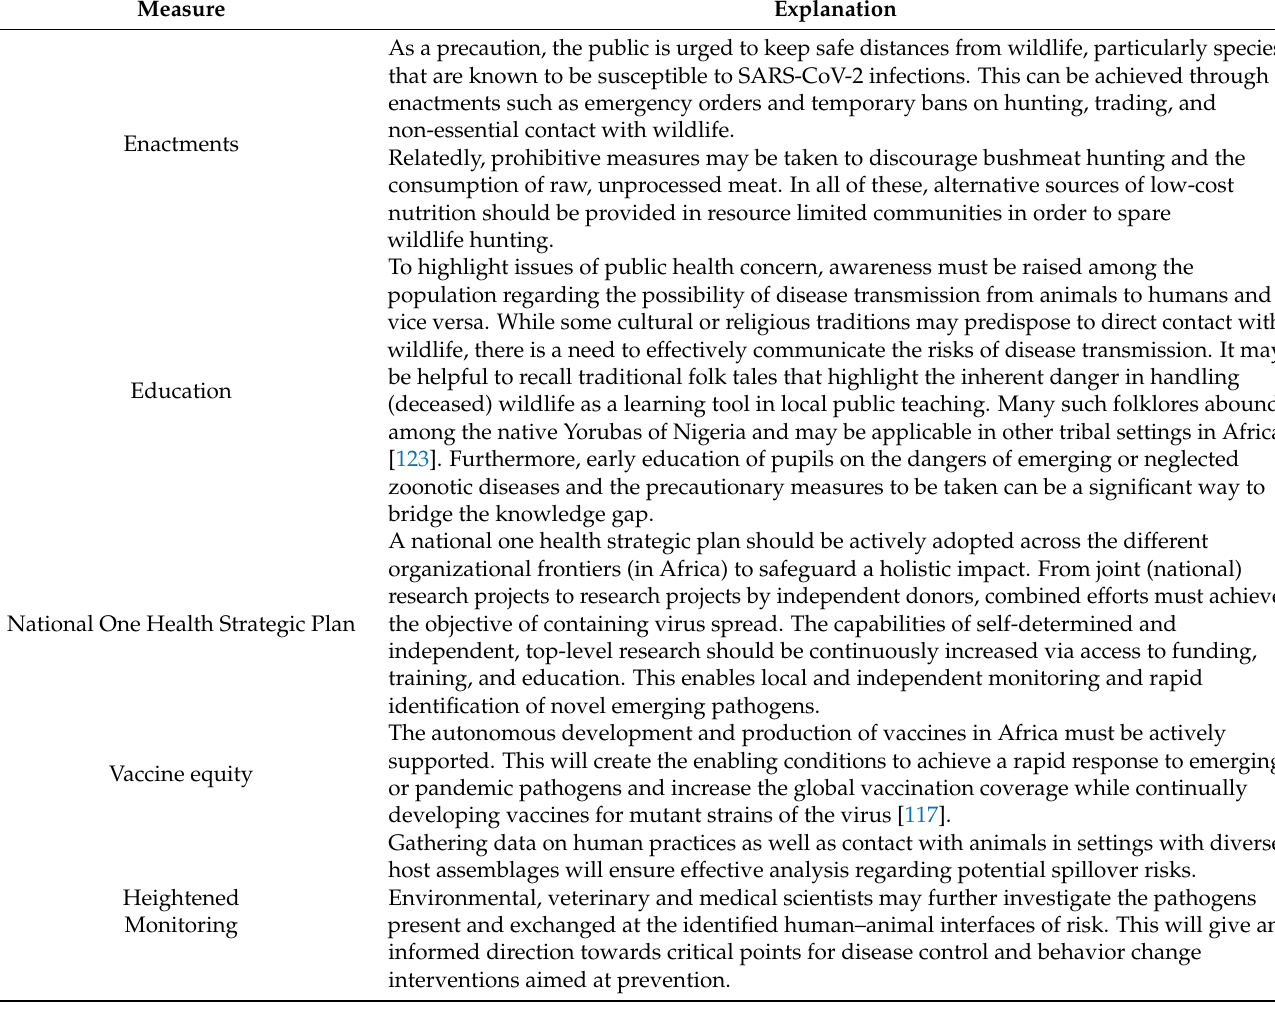
Table 1. Resolutions suggested to tackle zoonotic spillover infections and related